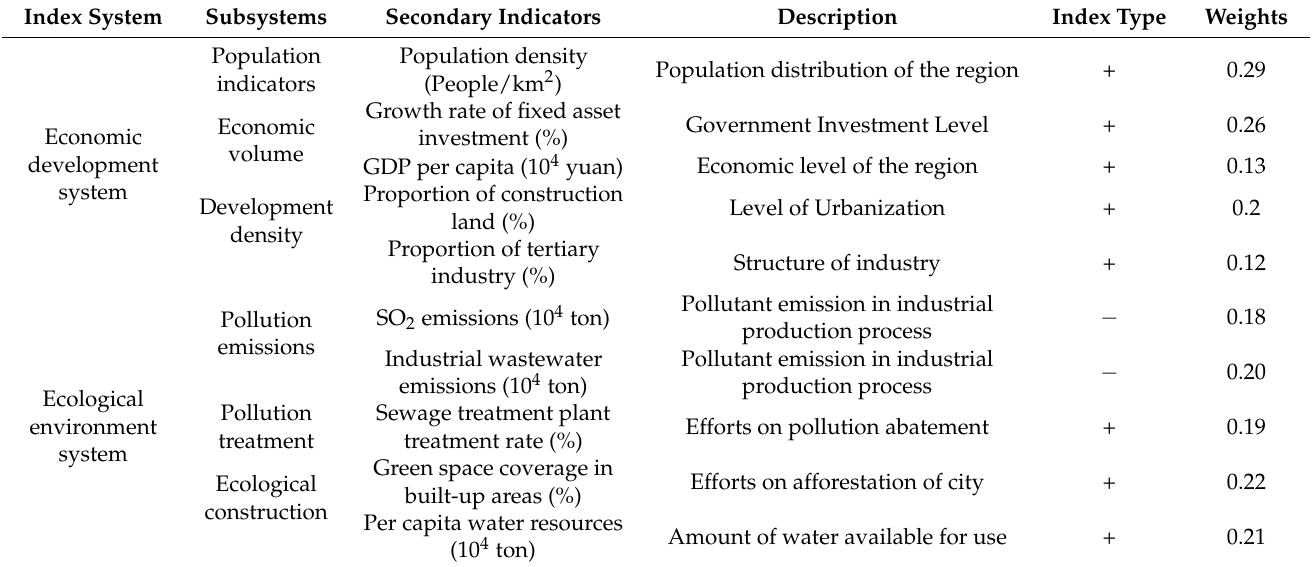
Table 1. Index system of economic development and resources of the